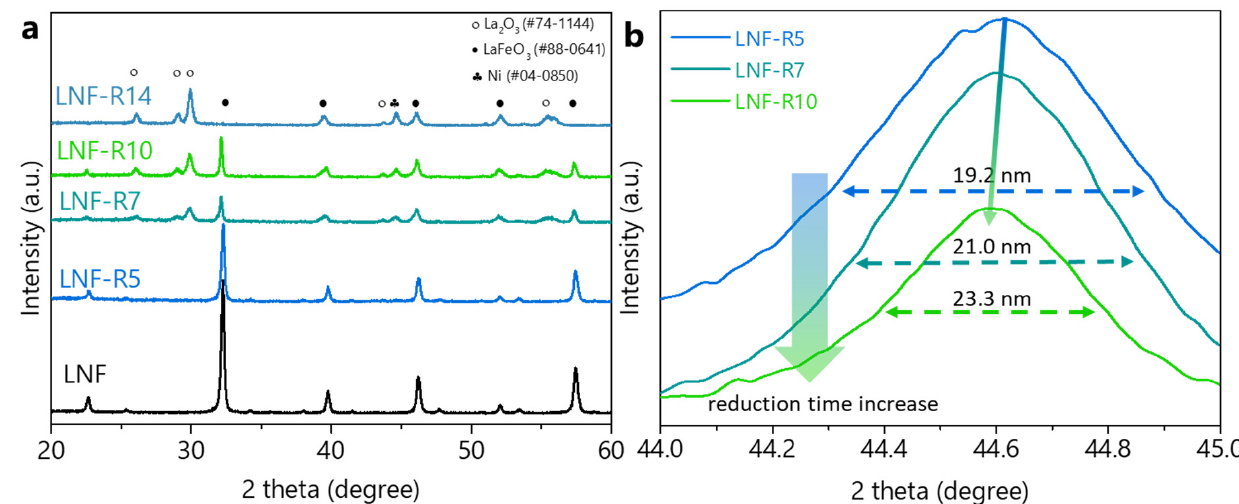
Figure 1. Powder sample characterization. ( a ) X-ray diffraction patterns of LNF before and after reduction for 5, 7, 10, and 14 h; ( b ) 2 theta from 44° to 45°.